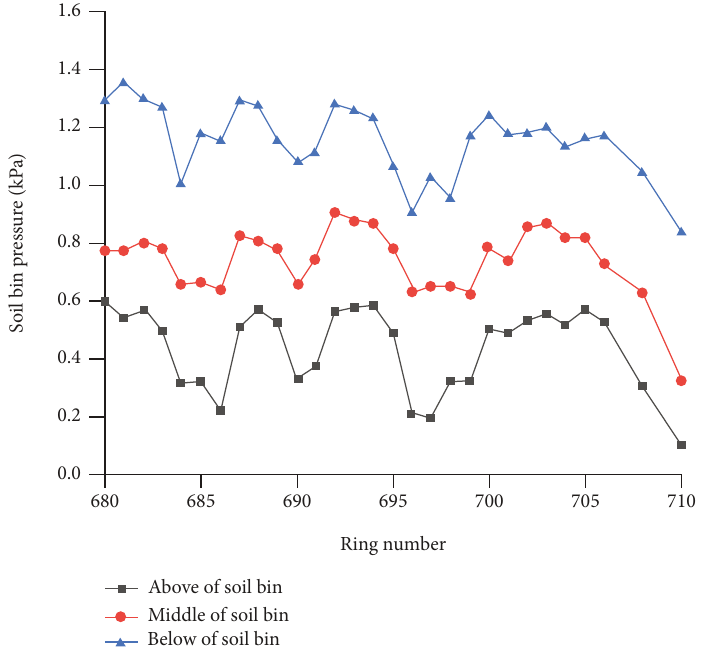
Figure 4: Measured result of soil pressure on the left